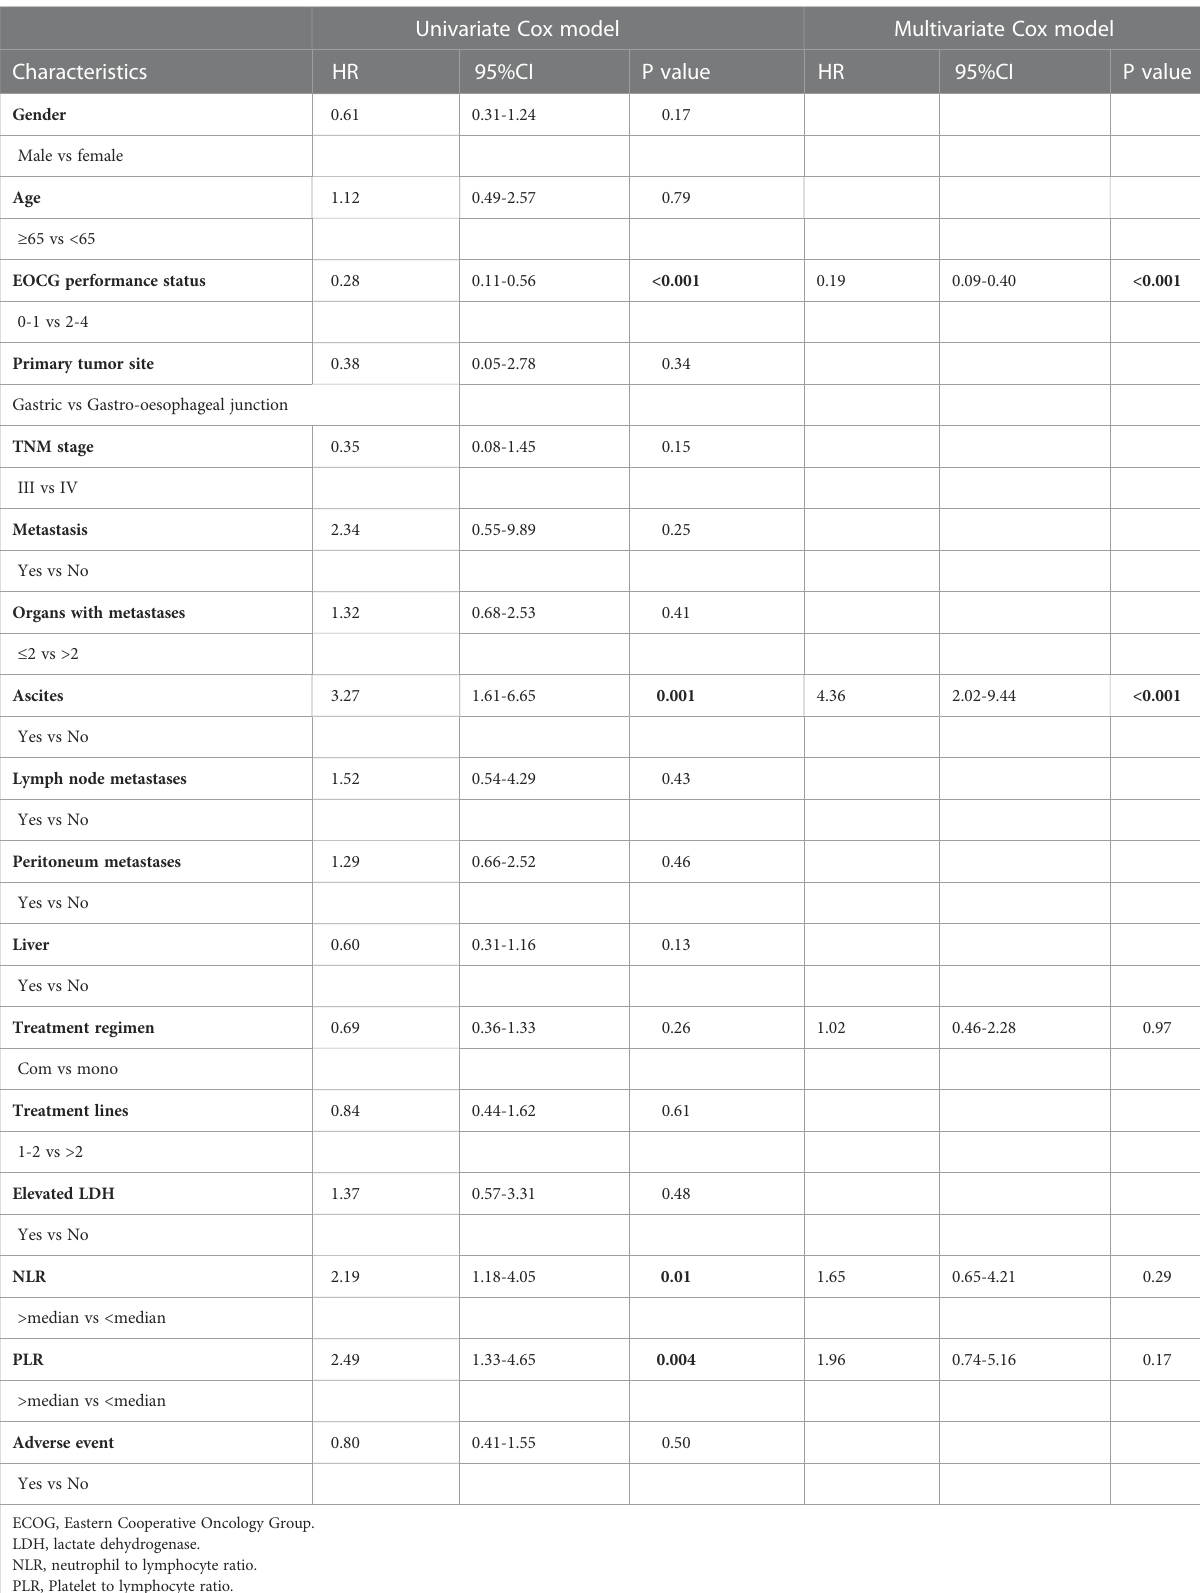
TABLE 1 Baseline demographic and clinical characteristics of GC/GEJC